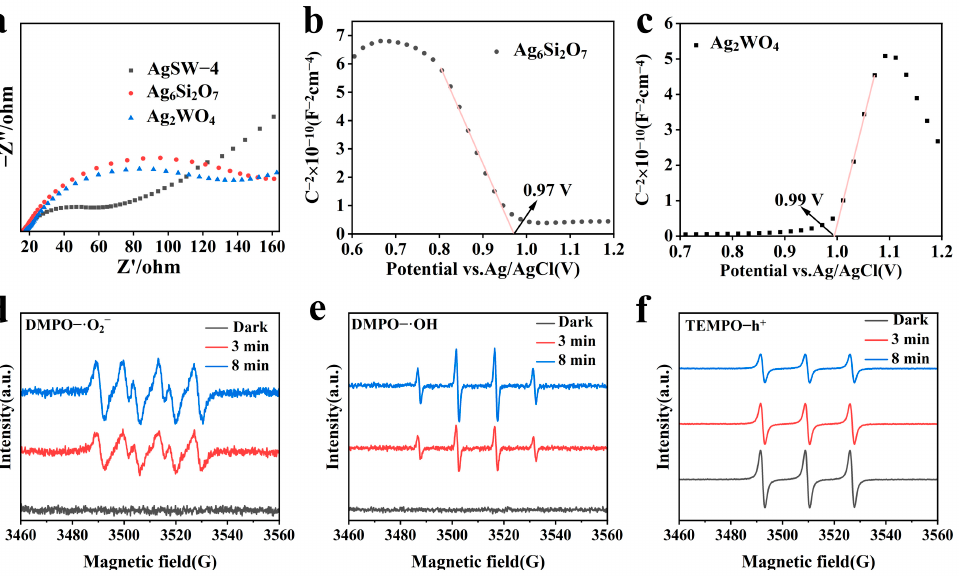
Figure 6. ( a ) Electrochemical impedance spectroscopy of AgSW-4, Ag 2 WO 4 , and Ag 6 Si 2 O 7 . MS plots of samples ( b ) Ag 2 WO 4 and ( c ) Ag 6 Si 2 O 7 . ESR analysis of AgSW-4 sample: ( d ) superoxide anion radicals (·O 2 − ), and ( e ) hydroxyl radicals (·OH) and ( f ) holes (h + ).